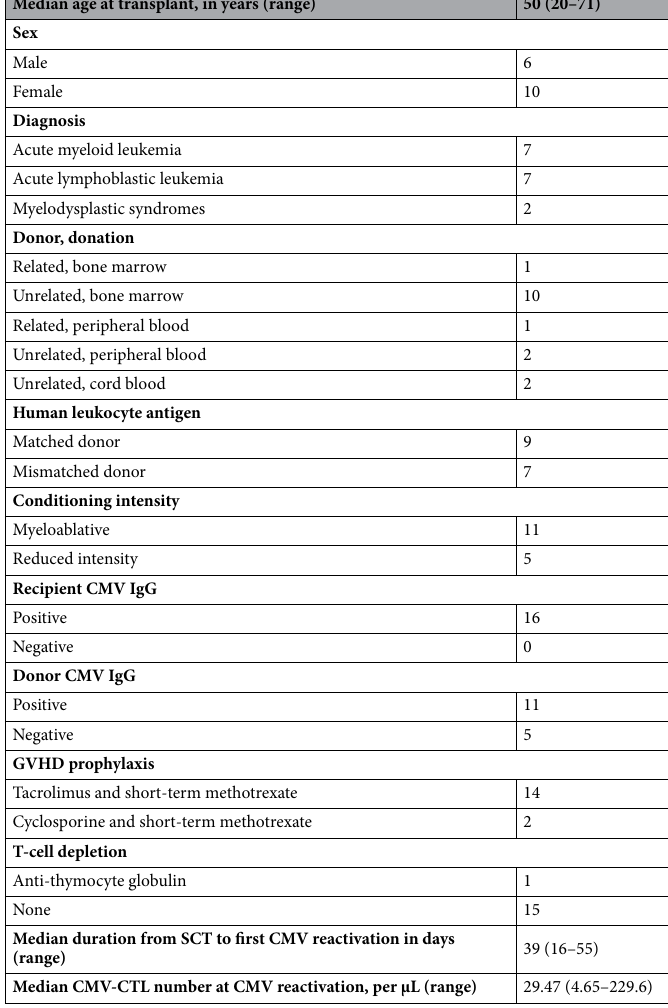
Table 1. Patient characteristics. CMV cytomegalovirus, CTL cytotoxic T-cell, SCT stem cell